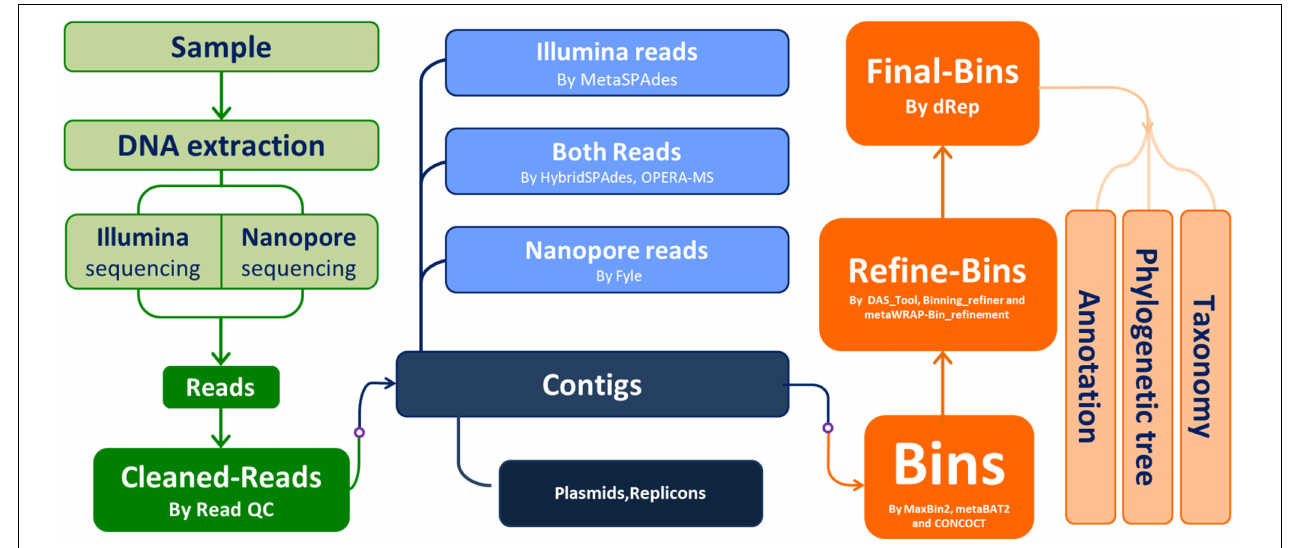
FIGURE 1 | Workflow of this study. The starting sample was the stool sample from a “healthy” Chinese young man.